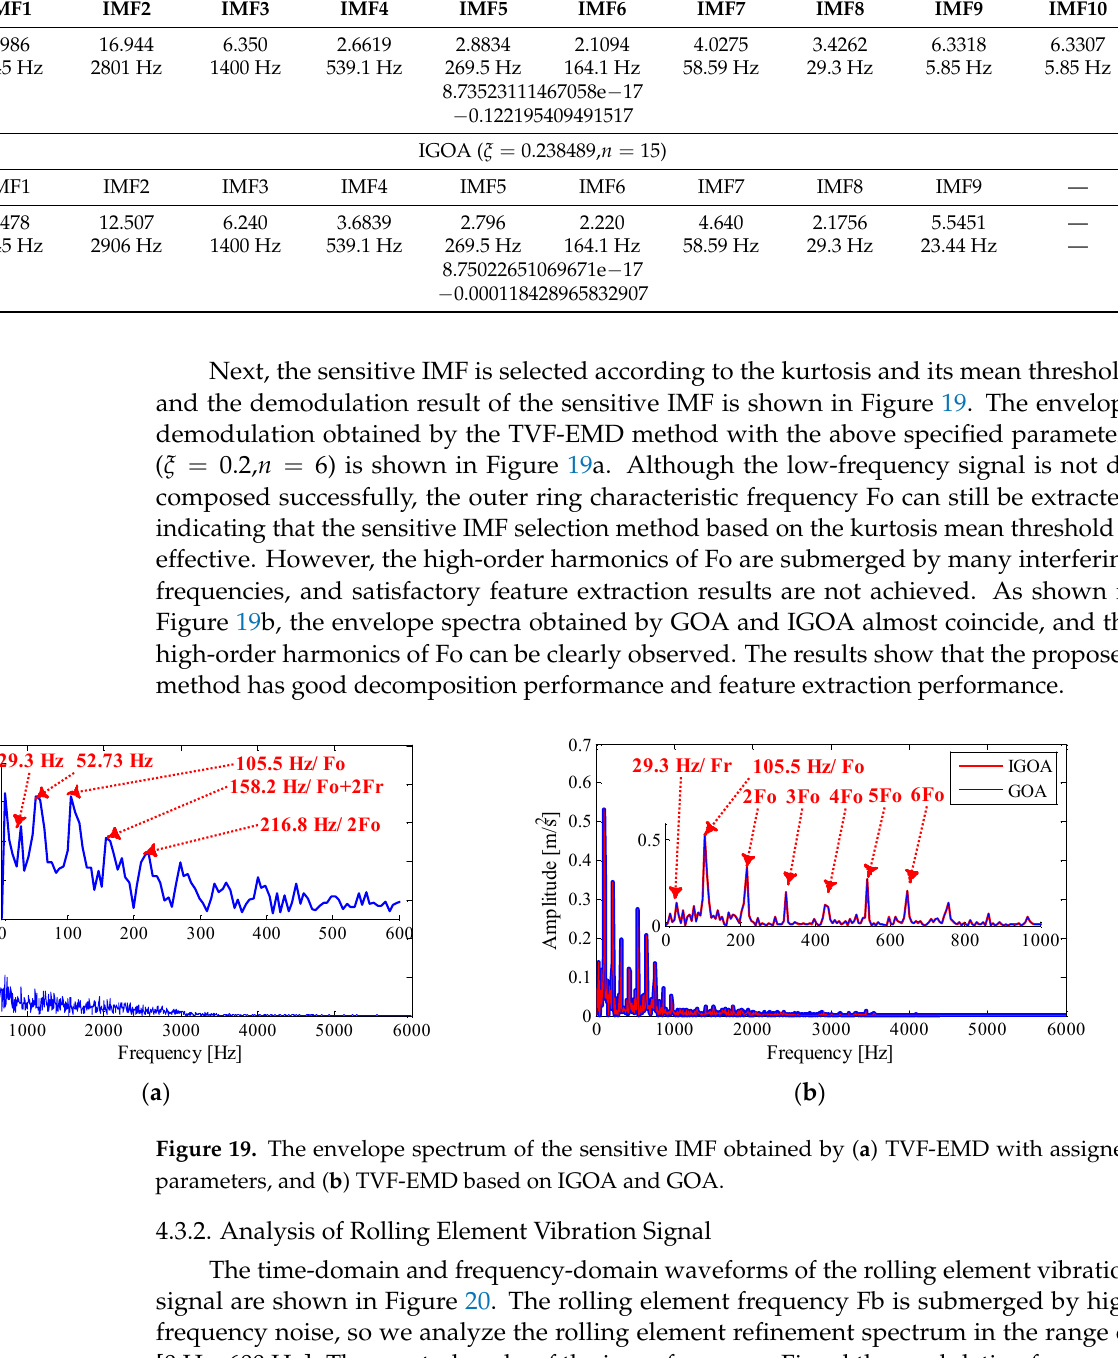
Table 10. Decomposition results evaluation of outer ring slight damage signal under different parameters.